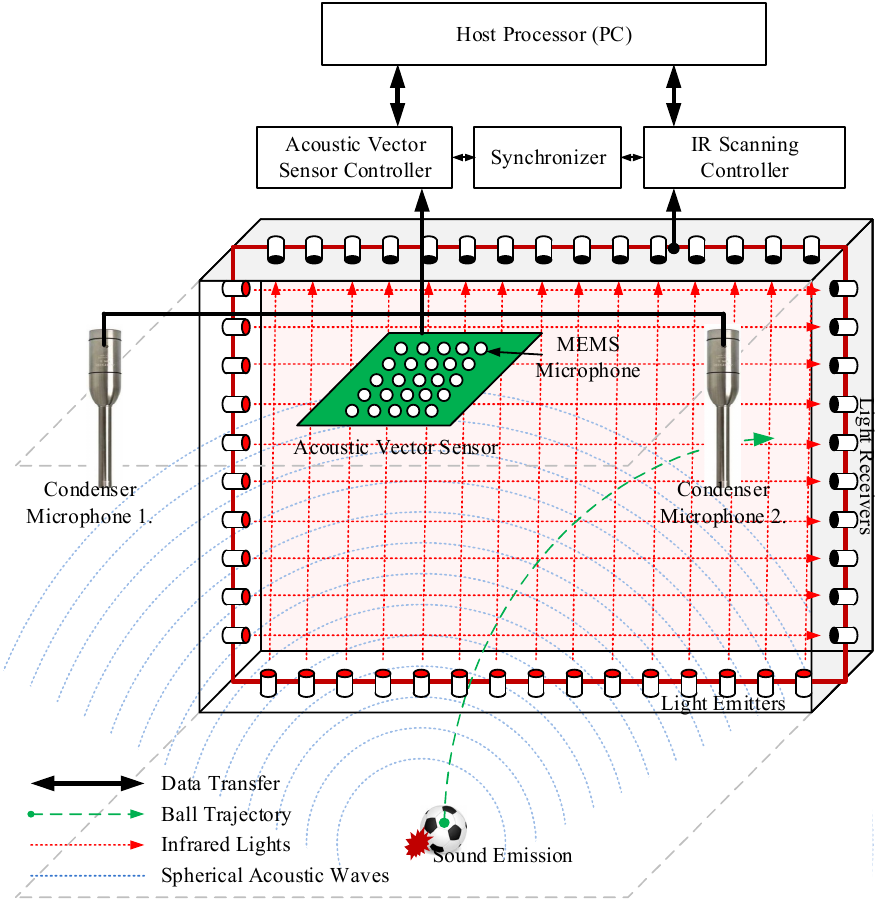
Figure 1. Overview of the proposed system: the spherical sound localization using the acoustic.